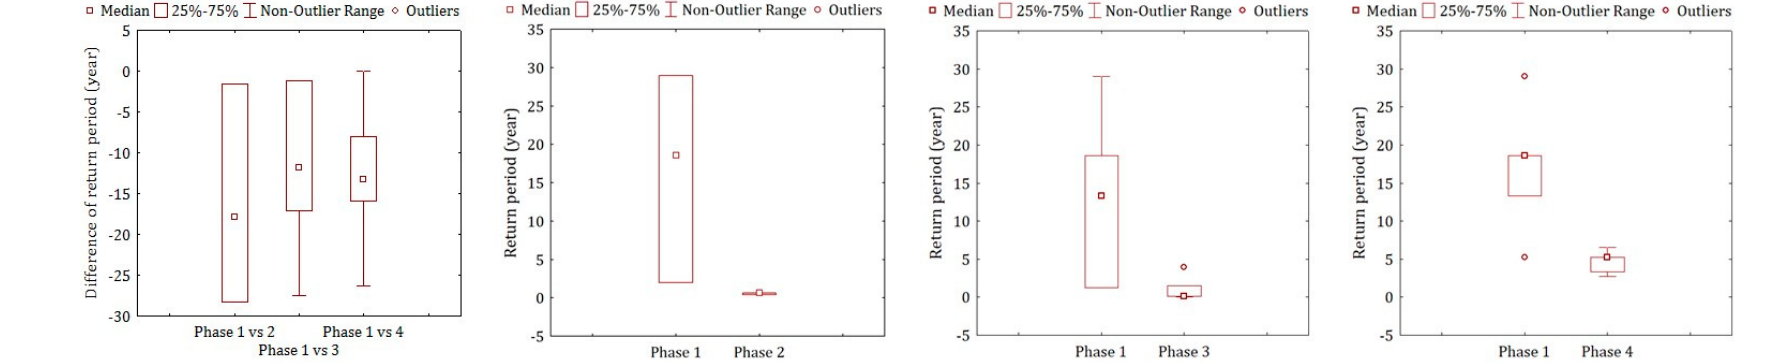
Figure 8. The comparison of the return period of low flows in different phases during the forest harvesting period.